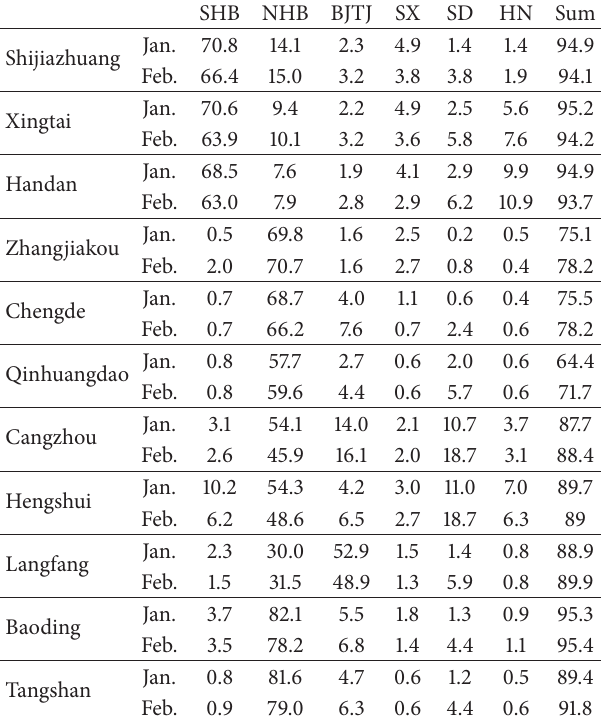
Table 2: The average spatial source contribution (%) to PM 2.5 concentrations in Hebei